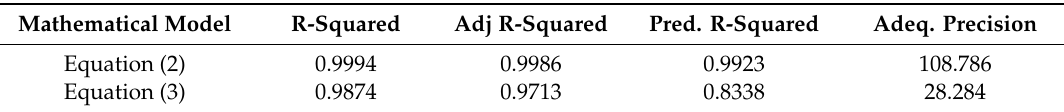
Table 6. Regression analysis for mathematical model.